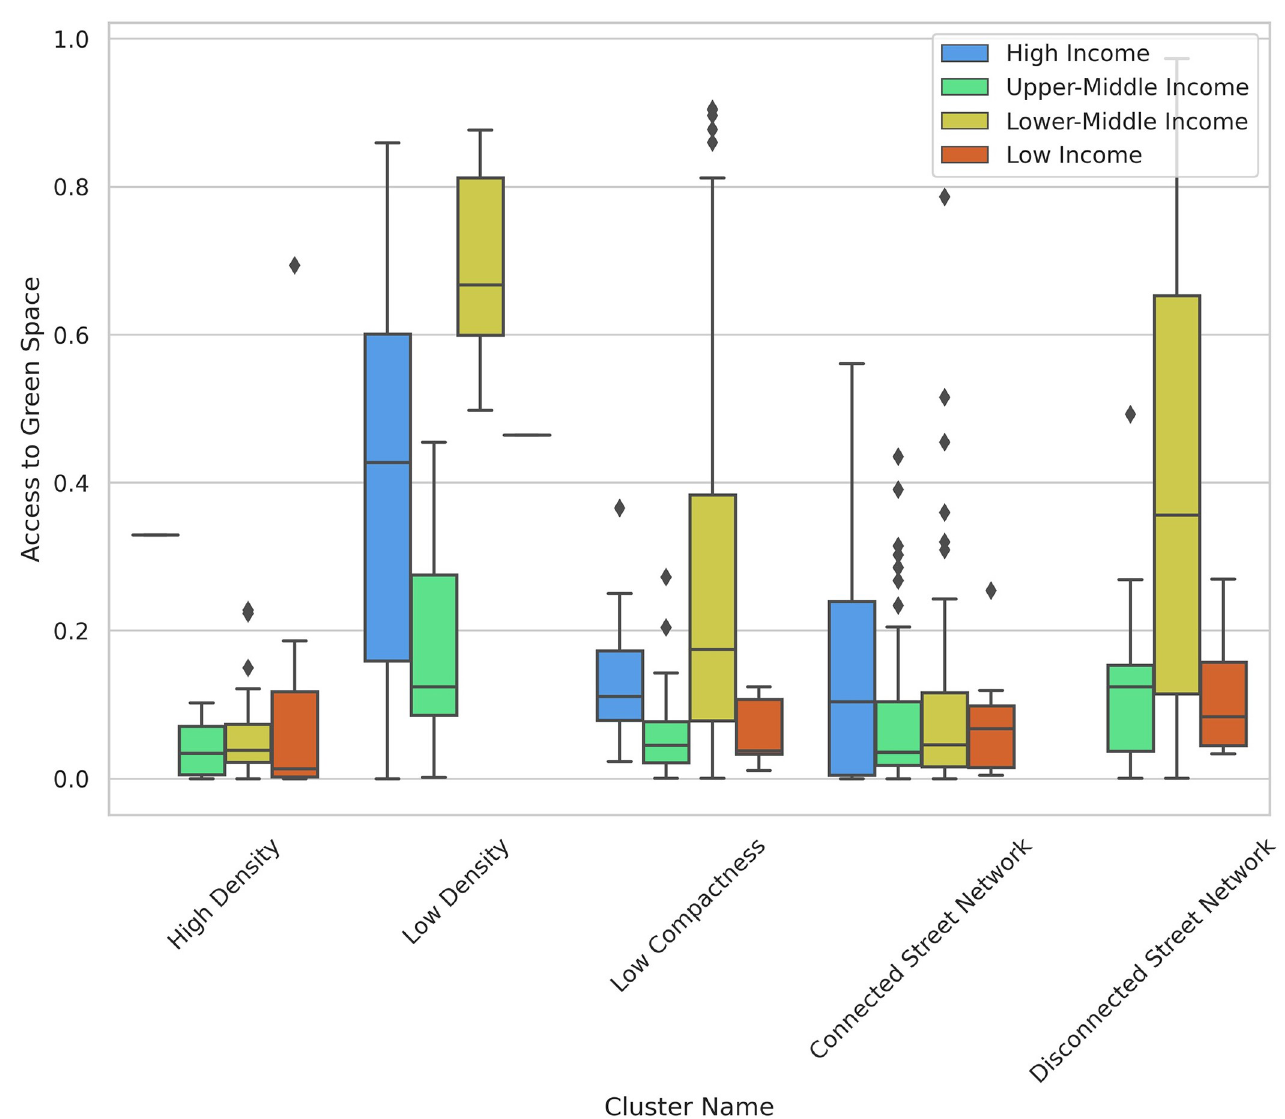
Fig 9. Box plot—share of population living in high green areas vs clusters across income